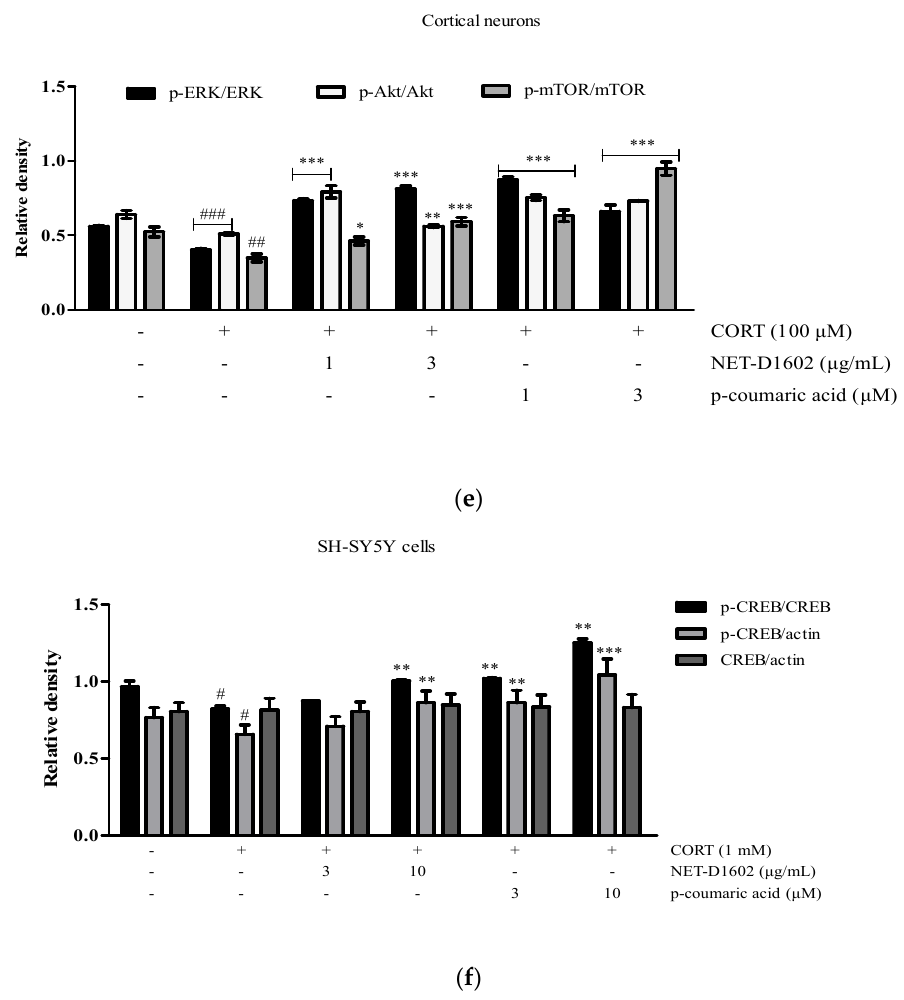
Figure 7. Effects of NET-D1602 and p- coumaric acid on ERK, Akt, mTOR, and CREB phosphorylation of SH-SY5Y and primary cultured rat cortical neuron cells induced by CORT. ( a ) SH-SY5Y cells were pretreated with NET-D1602 or p- coumaric acid for 24 h, subsequently treated with CORT (1 mM), and analyzed by using Western blotting to determine the immunoreactive bands for p- ERKs/ERKs, p- Akt/Akt, p- mTOR/mTOR, β -actin, and ( c ) p- CREB/CREB. ( b ) Primary cultured cortical neurons were pretreated with NET-D1602 or p- coumaric acid for 15 min, exposed to CORT (100 μ M) for 30 min, and analyzed by using Western blotting to determine the immunoreactive bands for p- ERKs/ERKs, p- Akt/Akt, p- mTOR/mTOR, and β -actin. ( d – f ) The quantitative analyses were expressed as relative changes from the levels of respective control. # p < 0.05, ## p < 0.01, and ### p < 0.001 compared to that of the untreated group; * p < 0.05, ** p < 0.01, and *** p < 0.001 compared to that of the CORT group. Akt, protein kinase B; CORT, corticosterone; CREB, cyclic AMP-responsive element-binding protein; ERK, extracellular signal-regulated kinases; NET-D1602, HP-20 resin fraction of the water extract of Vaccinium bracteatum leaves.